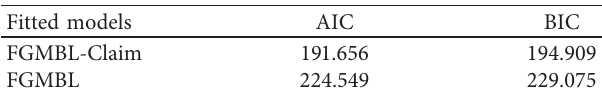
Table 7: Discrimination measures of the competing models for the economics